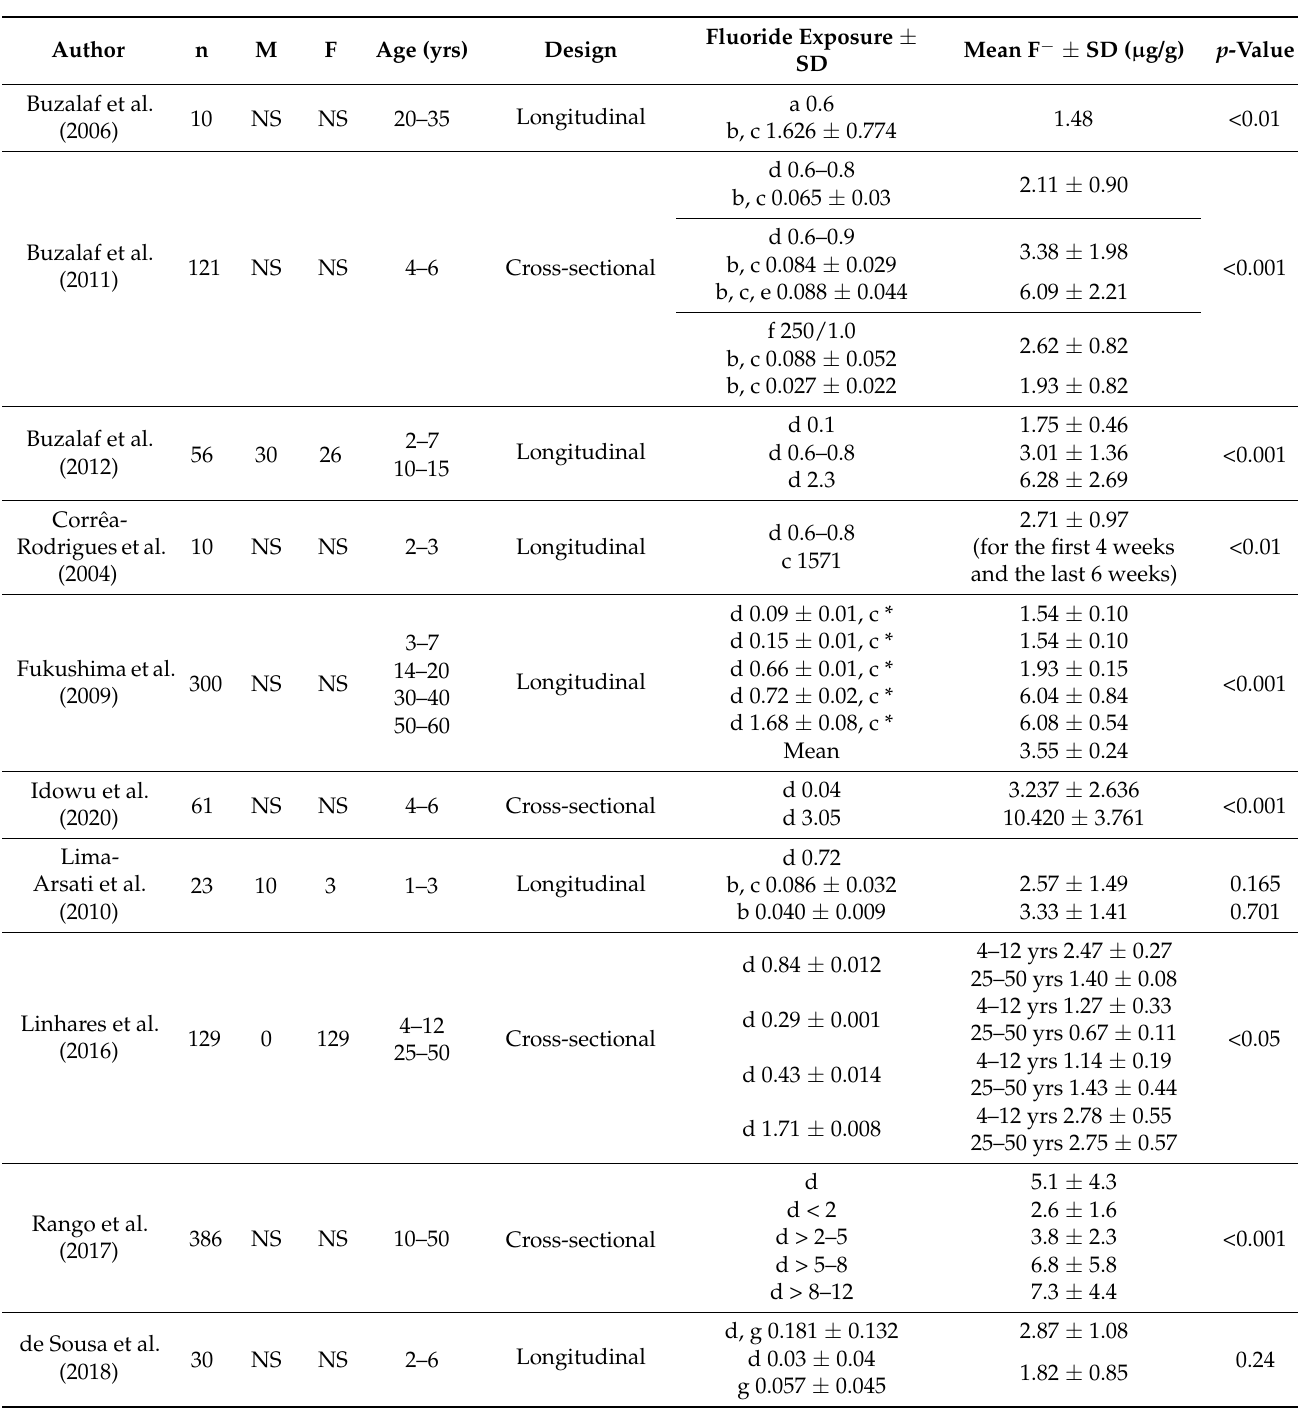
Table 1. Fluoride concentration in